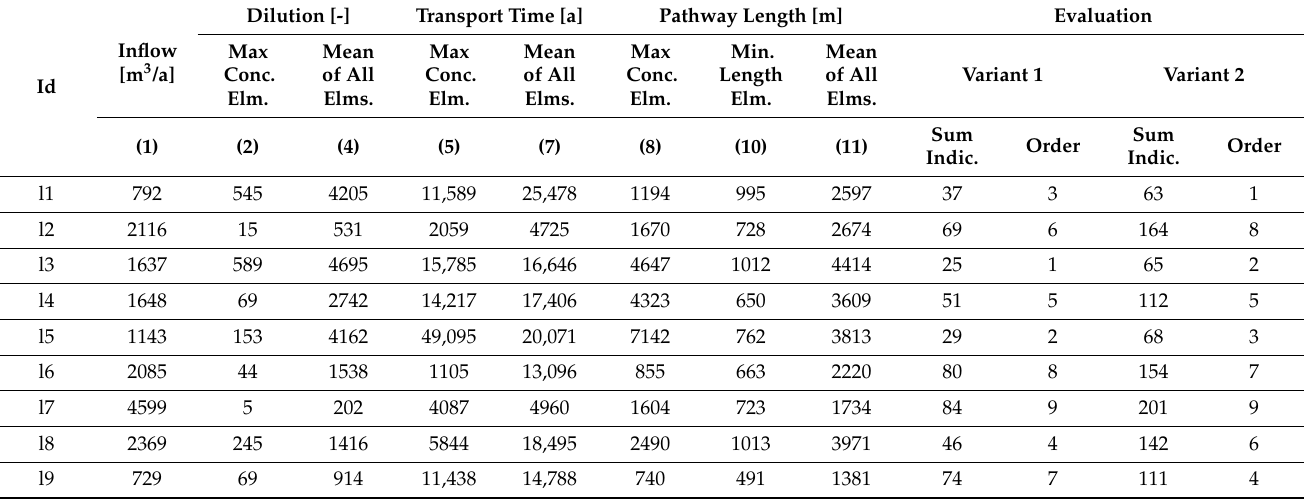
Table 1. Example of two variants (weight choice explained in the text) of the site evaluation, resulting in the order of suitability (selected indicators shown due to limited space: